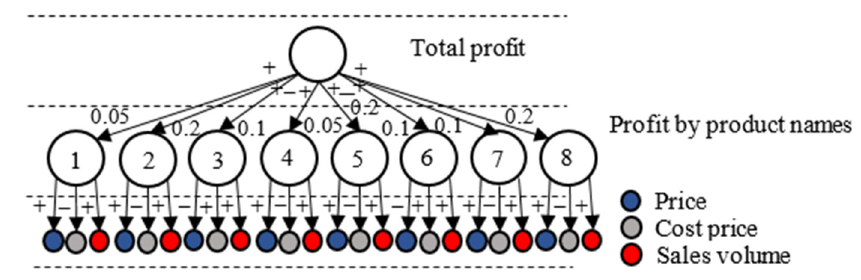
Figure 11. Factor tree for the problem of profit generation. Table 3 present the results of solving the problem of profit generation, equal to RUB 160,000 (the initial value of total profit was RUB 128,718.82). The values of Euclidean distance from set values represent the values close to zero. For comparison purposes,